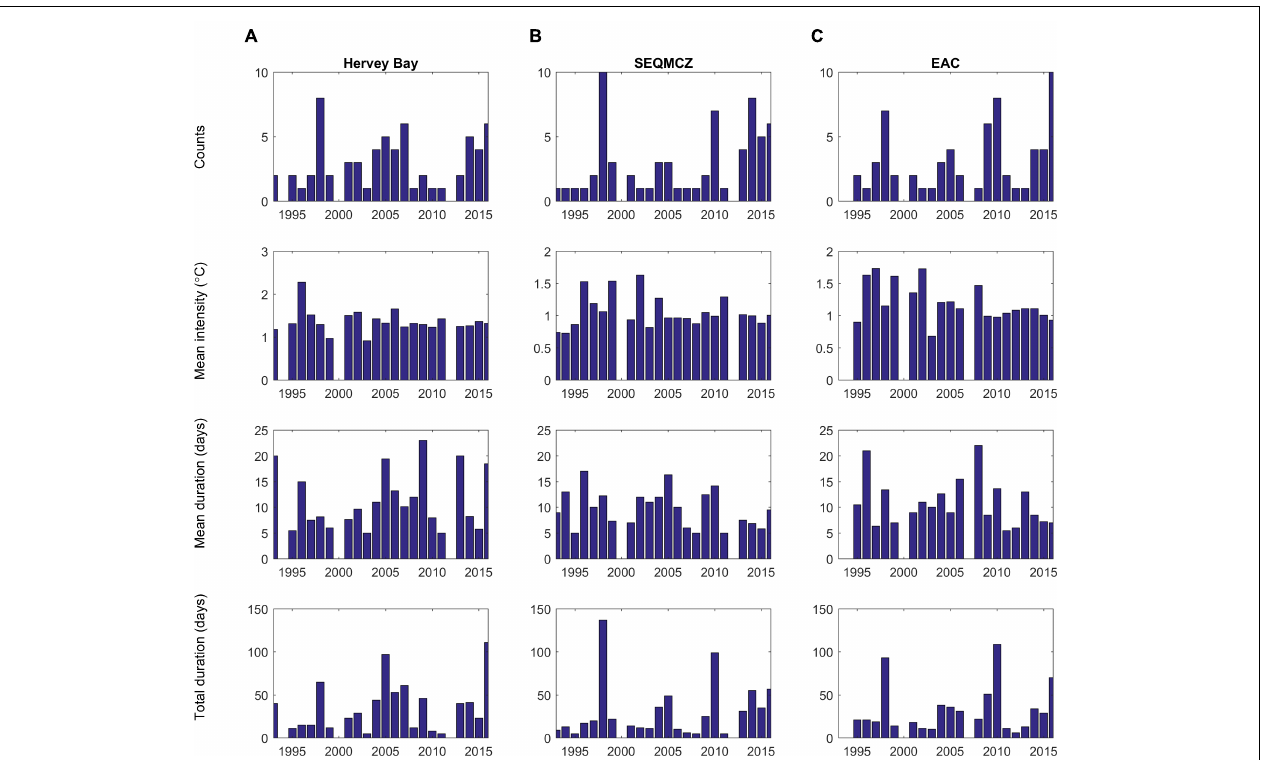
FIGURE 3 | Yearly MHW statistics for (A) Hervey Bay, (B) the SEQMCZ, and (C) the EAC. Top row: number of MHWs per year; second row: mean MHW intensity ( ◦ C); third row: mean MHW duration (days) and bottom row: total number of MHW days per year.